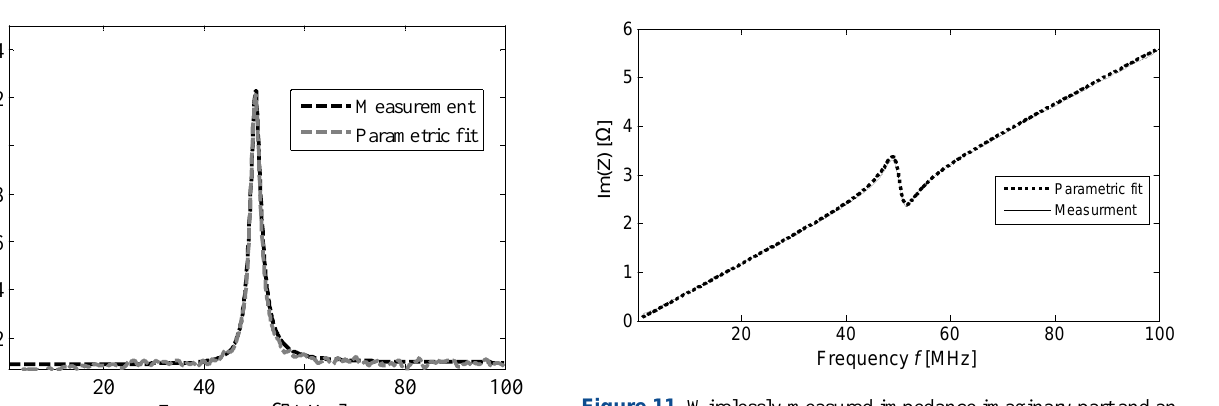
Figure 11. Wirelessly measured impedance imaginary part and an- alytical fit for a micro coil with resonance frequency of 51.19MHz with an error of 0.41%.